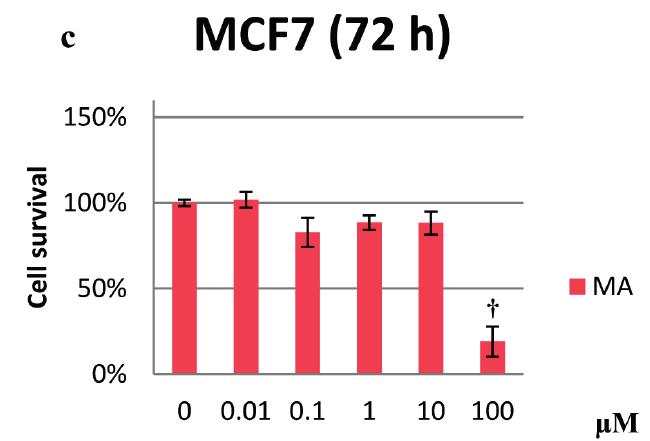
Figure 3. Percentage of cell proliferation in MCF7 cells after treatment with 0.01 µM to 100 µM MA at 24 ( a ); 48 ( b ) and 72 h ( c ). Values represent the mean ± SEM of three independent experiments. Statistically significant differences are represented by (†) for MA at p < 0.05 with respect to the untreated control.